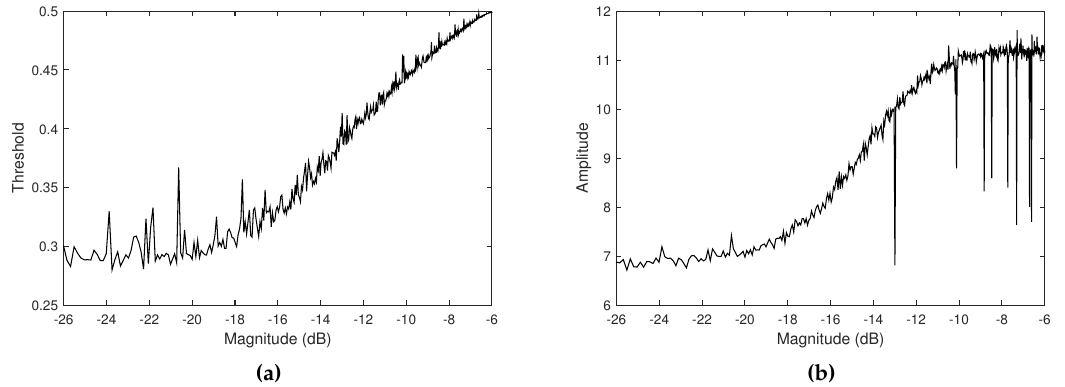
Figure 7. ( a ) Low threshold and ( b ) average peak amplitude curves of the feedback signals according to volume level of ambient noise. Ambient noise is simulated using different volumes of white noises.